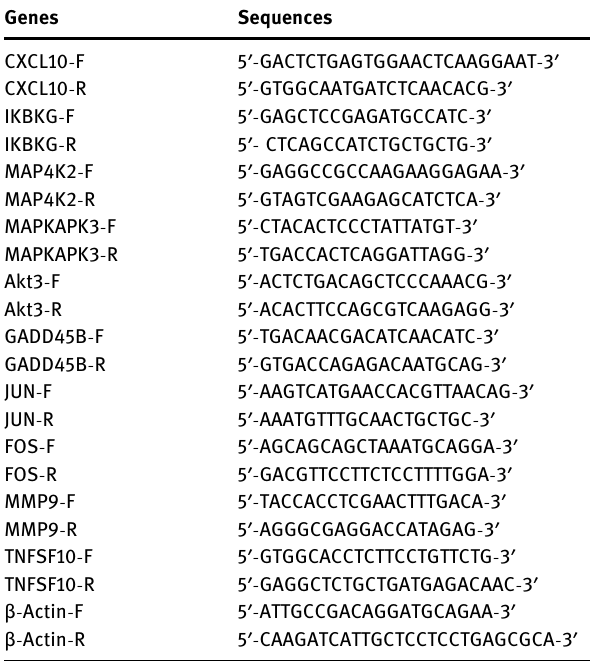
Table 1: Sequences of primers used in the experiment